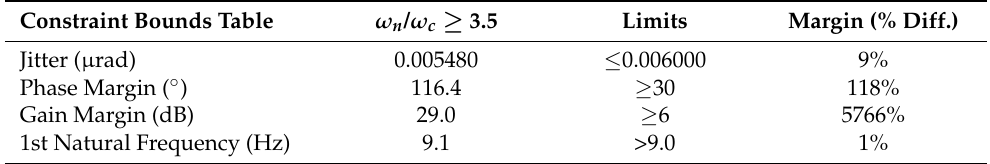
Table 1. Numerical results of constrained, feasible, “bound” system design. Constraint Bounds